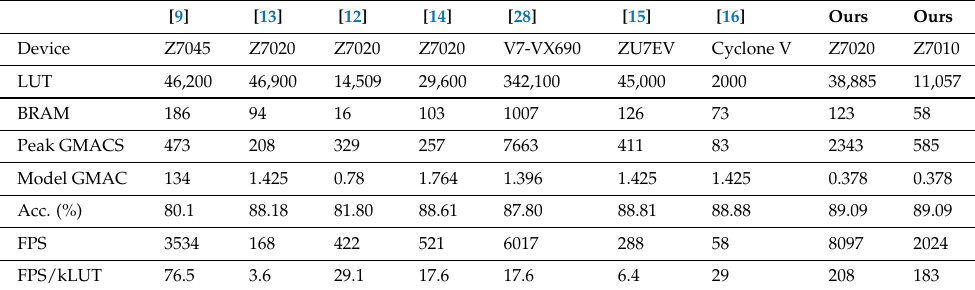
Table 4. Comparison with previous works for BCNN inference of